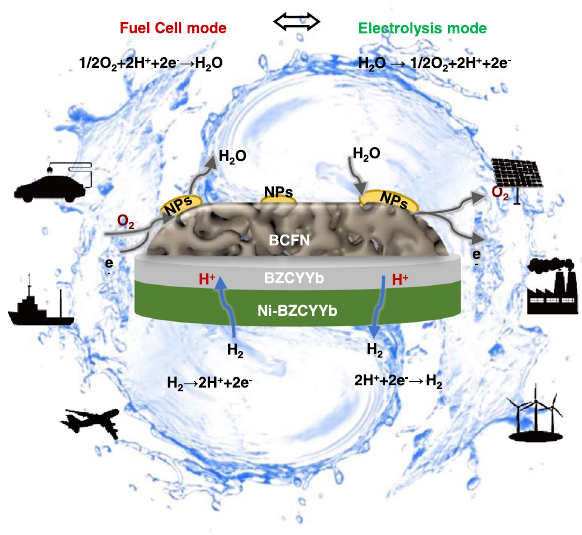
Fig. 1 Reactions on an R-PCEC and their applications. Schematic illustration of an R-PCEC with a steam-induced surface restructured BCFN air electrode operated in both FC and EL